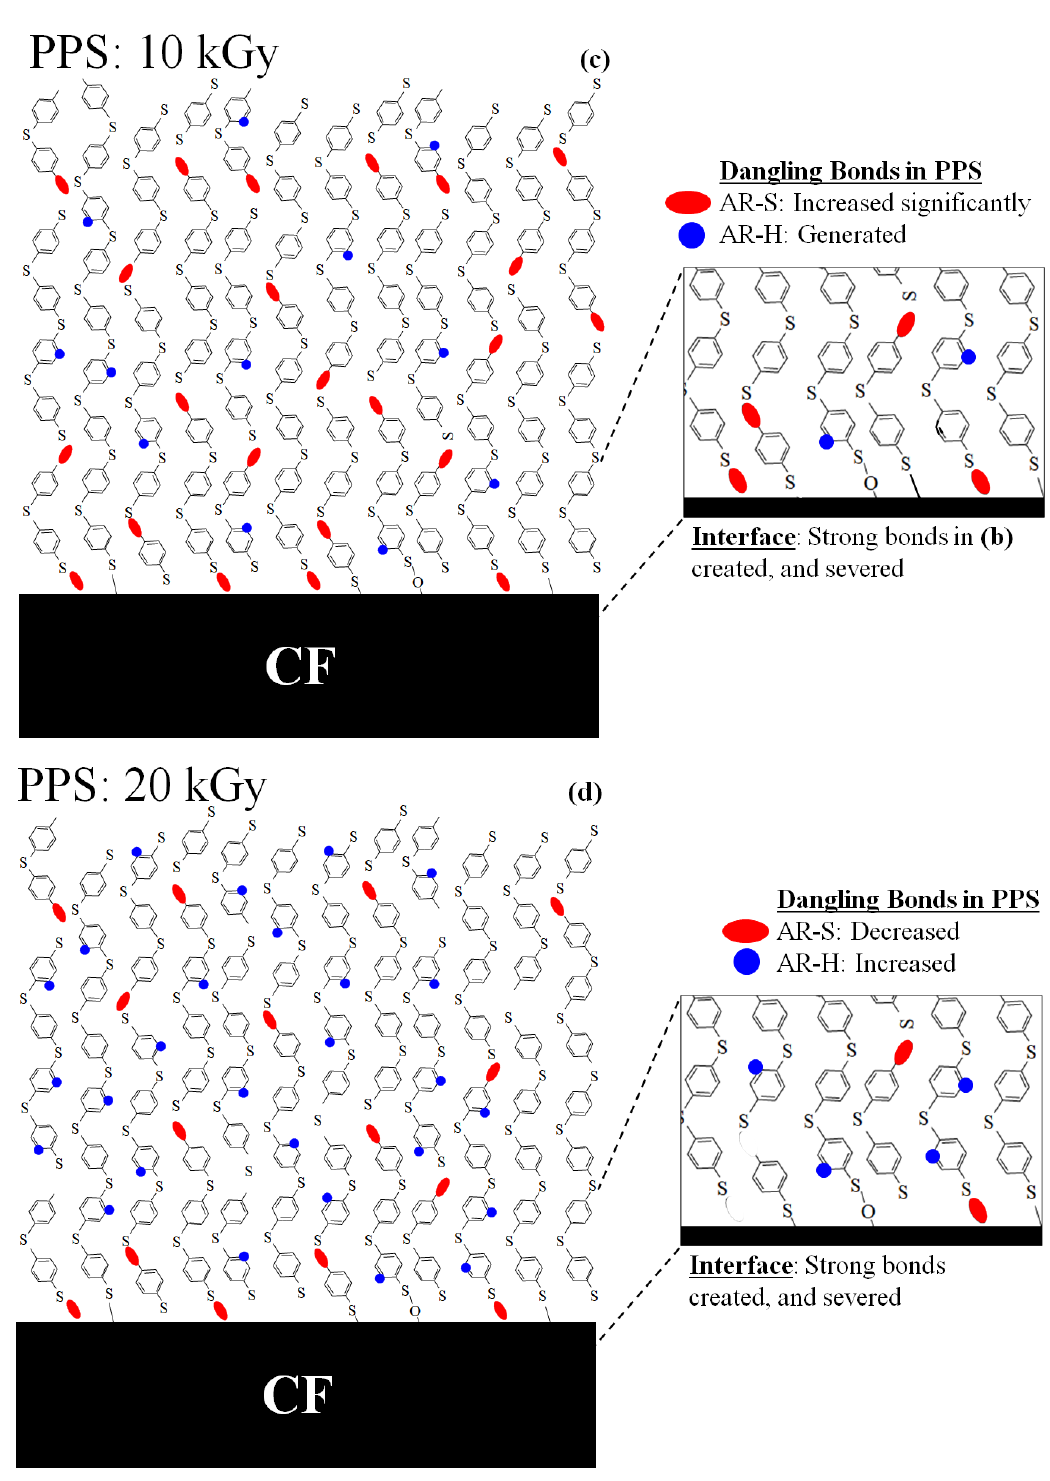
Figure 15. Proposed model of a strengthening mechanism by HLEBI within the PPS matrix and at the CF/PPS interface for: ( a ) untreated, ( b ) 5 kGy, ( c ) 10 kGy, and ( d ) 20 kGy [PPS] 4 [CF] 3 samples, respectively. AR-S and AR-H dangling bonds are modelled as red ellipses and blue dots, respectively. Note that the number of bonds shown is arbitrary; the purpose is just to model trends by the HLEBI.